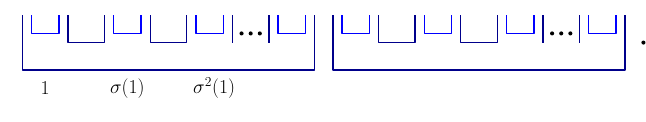
Figure 7 . Diagram used to prove the triangle